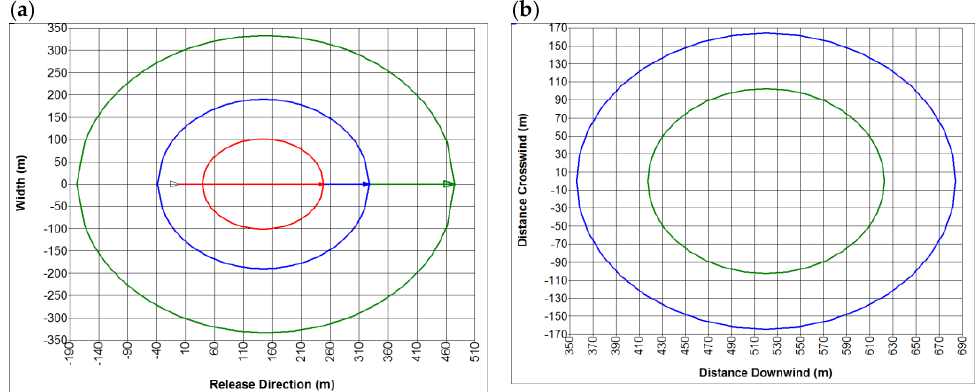
Figure 17. Hazard zones due to a jet fire ( a ) and an explosion ( b ) for a natural gas pipeline (a = 0.5). The next figure shows the hazard zones for the same dangerous phenomena caused by natural gas release and ignition, but this time a complete rupture of the pipeline is assumed.